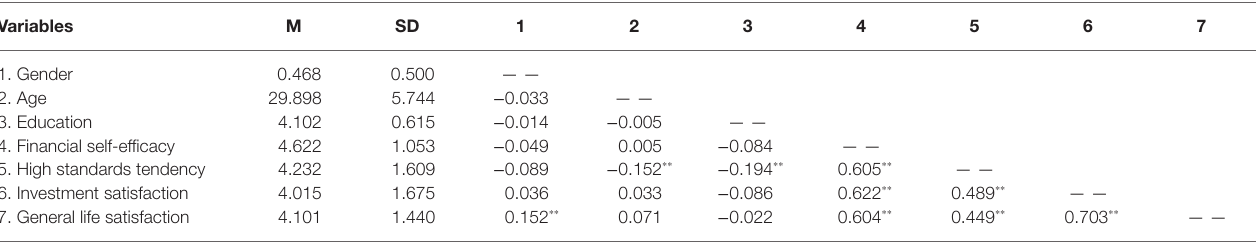
TABLE 1 | Means and standard deviations of all variables along with their correlations.